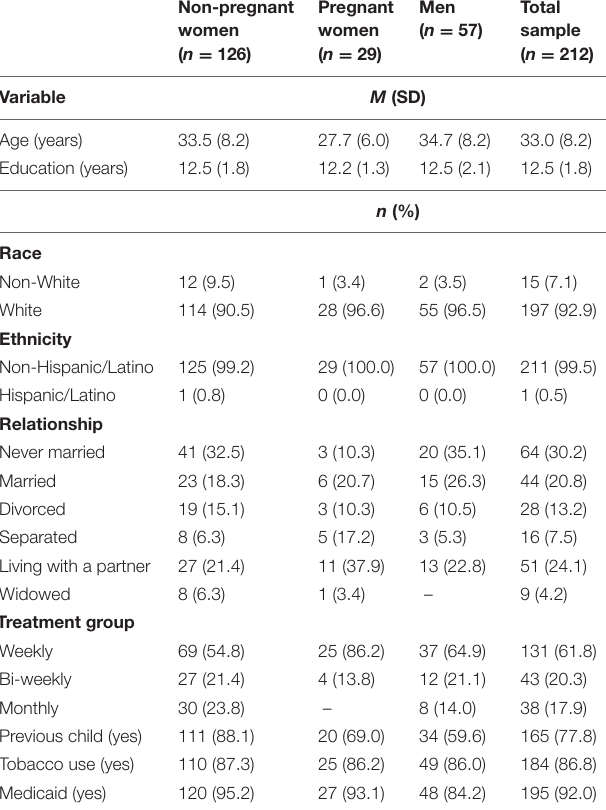
TABLE 1 | Participant